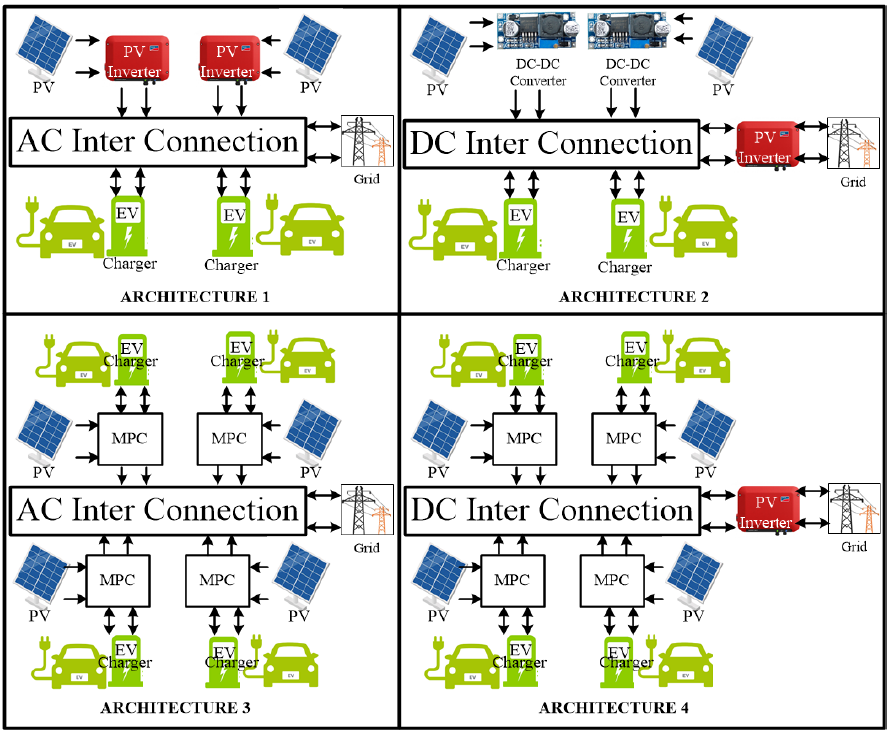
Figure 2. System architectures for electric vehicle (EV)—photovoltaic (PV) charging using multiport converters.